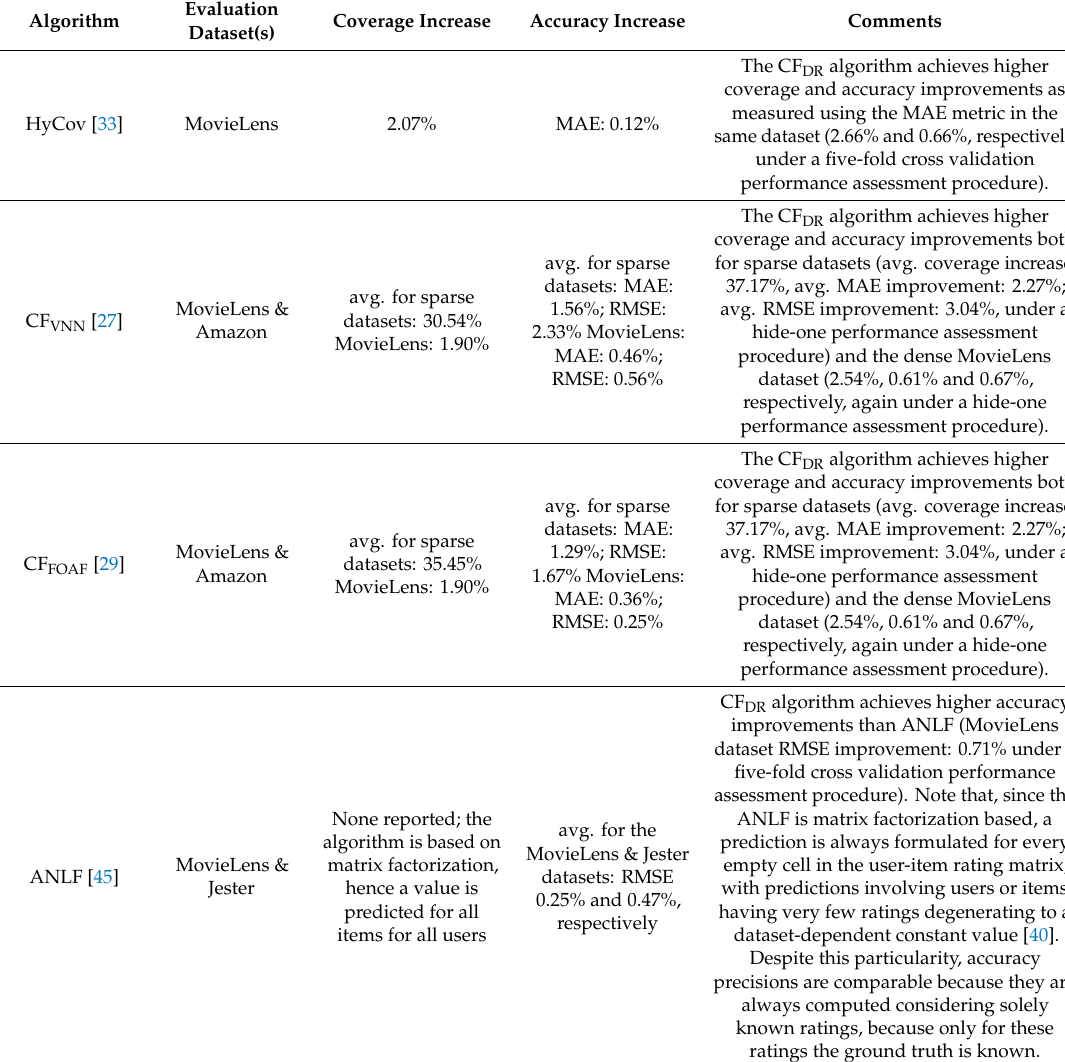
Table 5. Comparison of CF DR with algorithms that exploit only the user-item rating matrix for achieving coverage